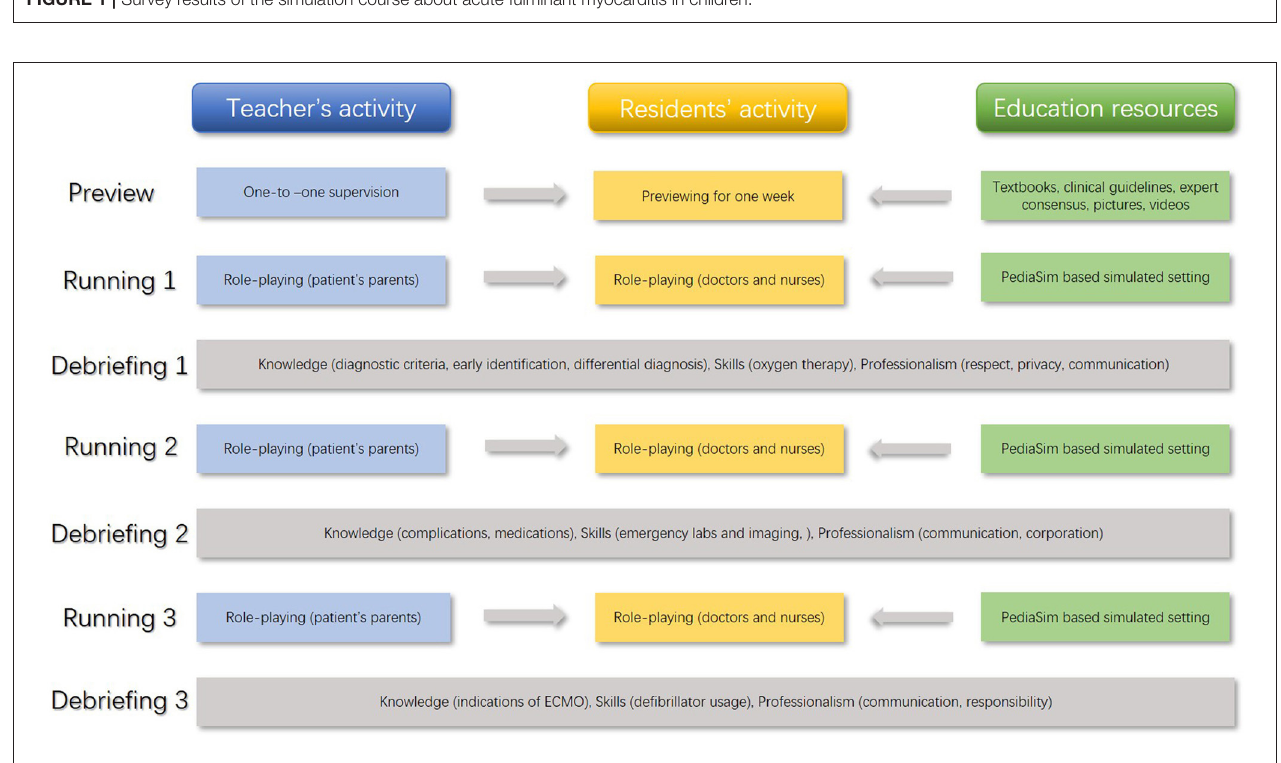
represents the 70% level, and any content above the 70% level was selected for the course. ECMO, Extracorporeal Membrane Oxygenation; BMC, Bone Marrow